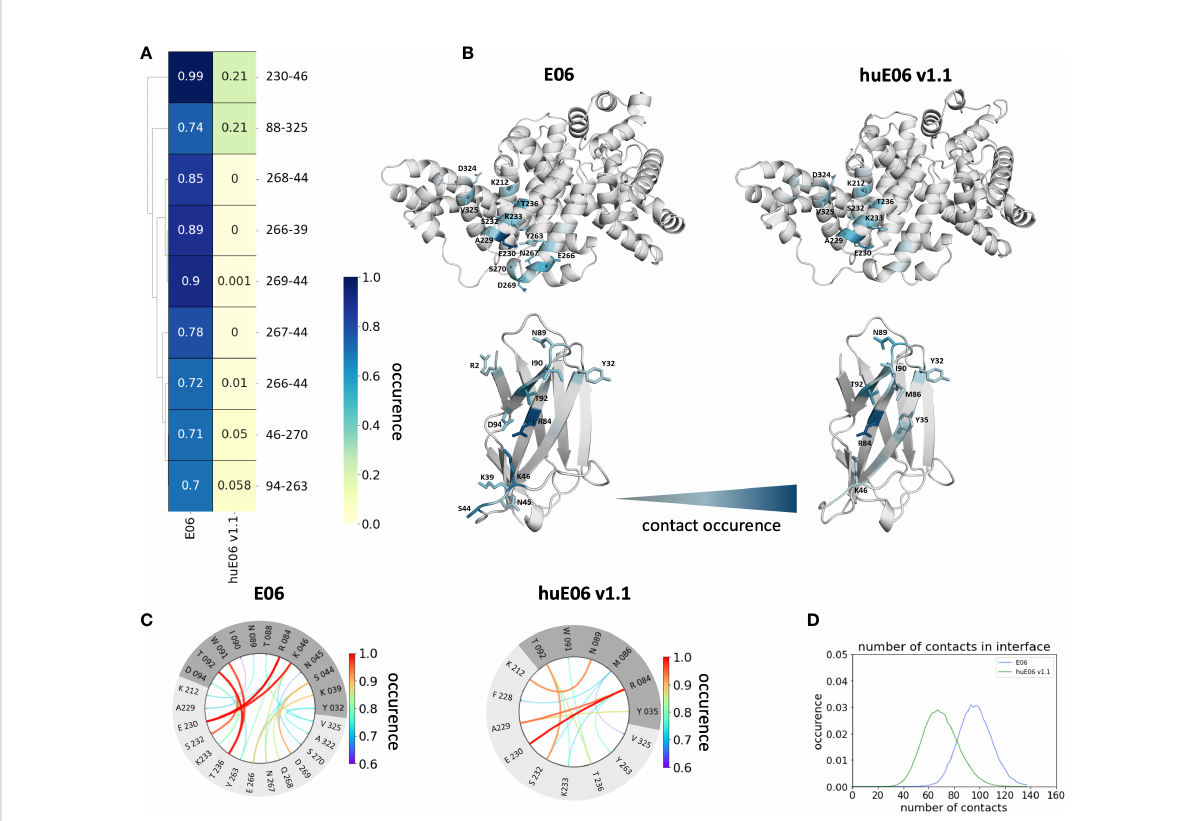
FIGURE 5 Contact analysis of the HSA antigen with the parent E06 VNAR and the huE06 v1.1. (A) Interaction fi ngerprint visualization of the contacts between antibody and antigen, depicts the differences in the contact frequencies between the parent and the humanized variant. (B) Interacting residues between antibody and antigen color-coded according to their occurrence. (C) Interaction fl areplots between antibody (dark grey) and antigen HSA (light grey). The color-coding of the lines in the fl areplots corresponds to the occurrence of the contacts. (D) Contacts per frame distributions for the interactions of the parent and the humanized variant with the antigen. The distribution of the parent is depicted in blue, the distribution of huE06 v1.1 is illustrated in